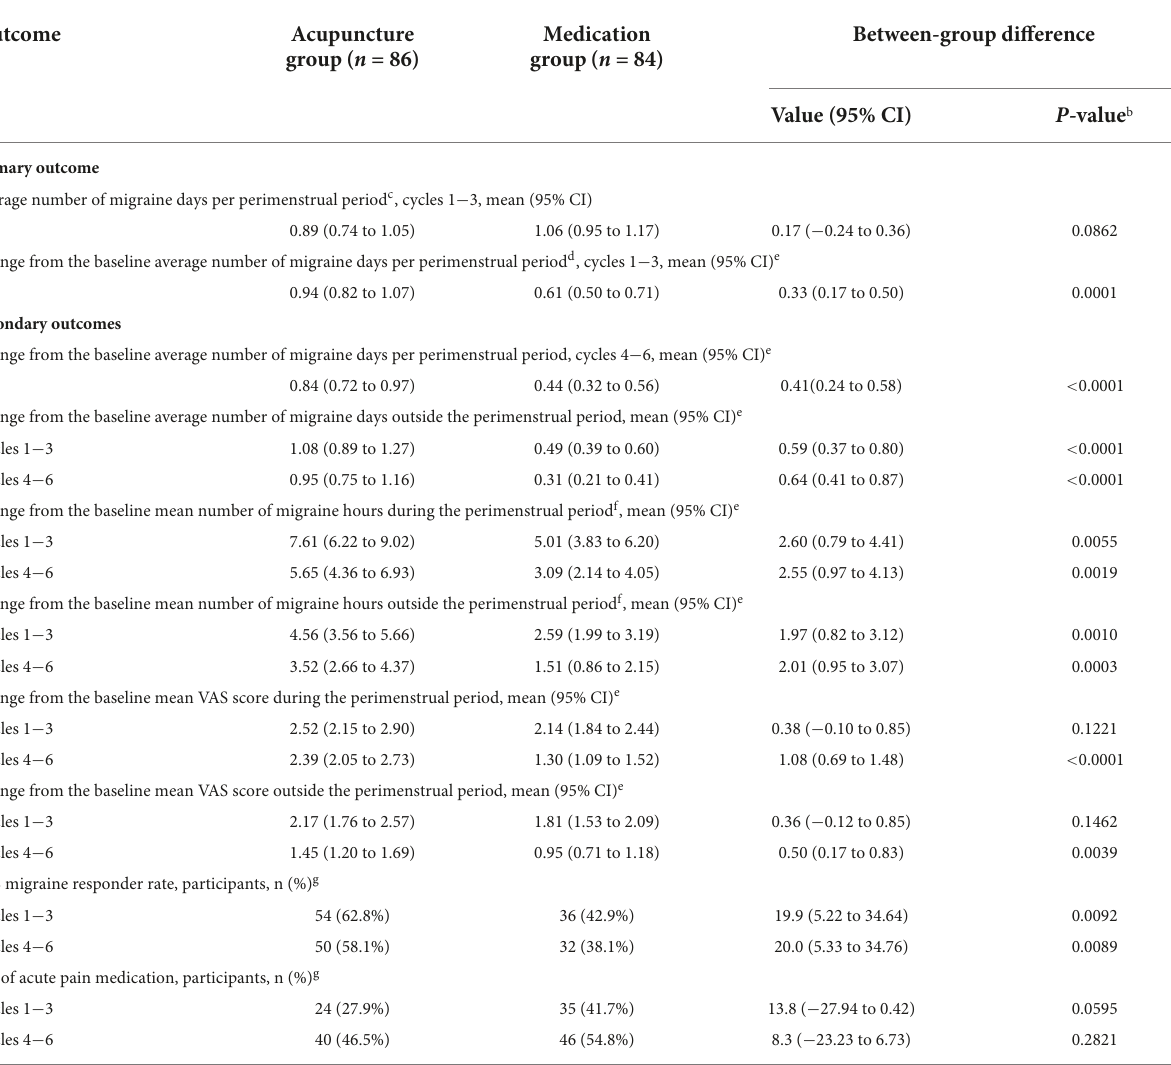
TABLE 2 Primary and secondary outcomes (intention-to-treat population) a